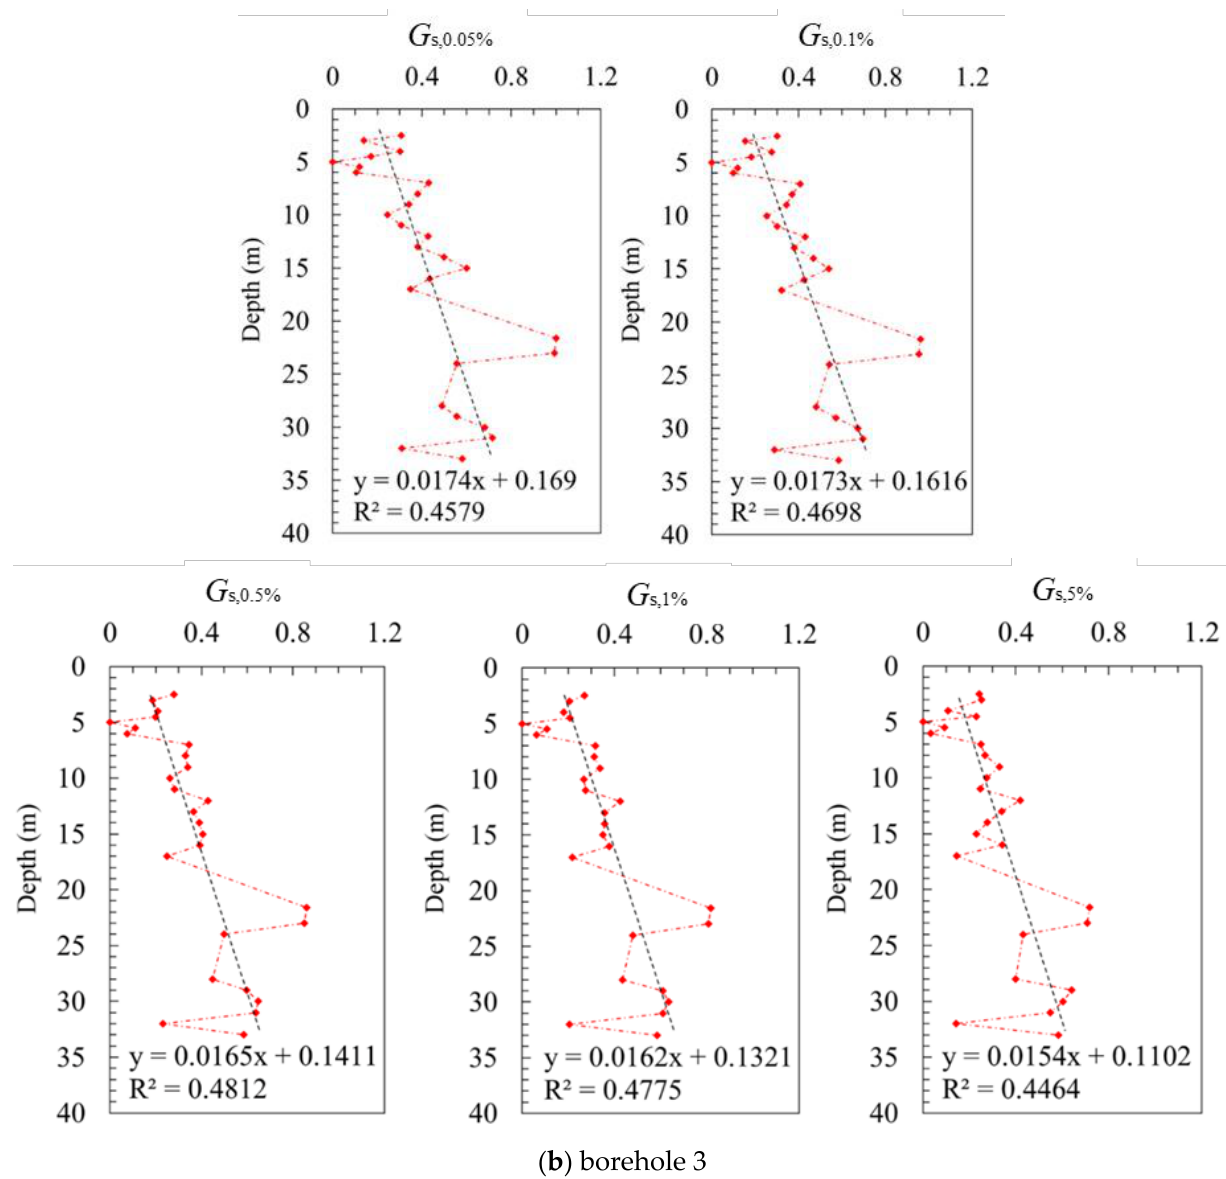
Figure 12. Distribution of normalized shear modulus s G at different shear strains along the depth for boreholes 2 and 3.